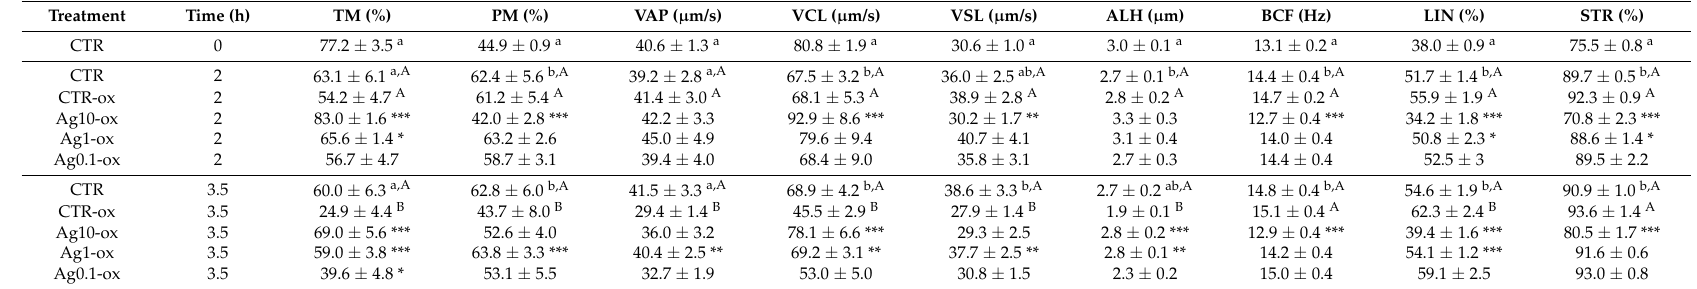
Table 2. Boar sperm kinetics in samples submitted to oxidative stress (CTR except) and supplemented with aminoguanidine.